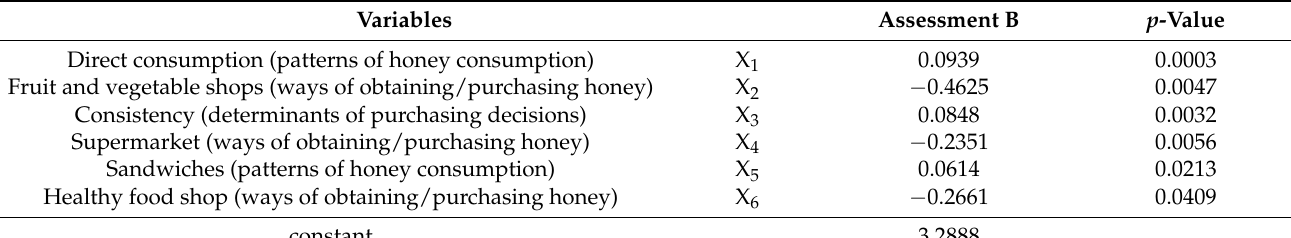
Table 6. Parameter values of the multiple regression